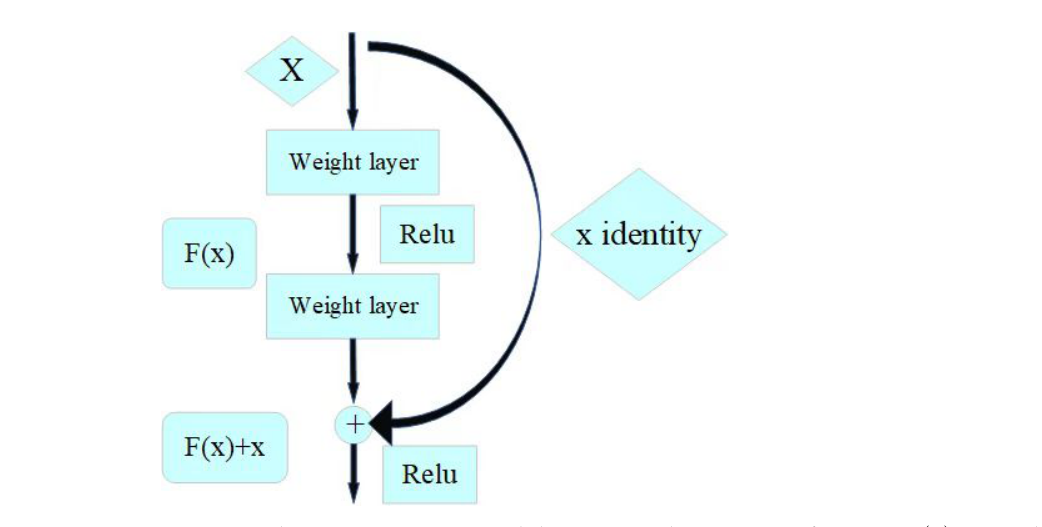
Figure 6. Shortcut connection module. ReLu is the activation function; F ( x ) + x is the original learning feature; x is the model input; F ( x ) is the